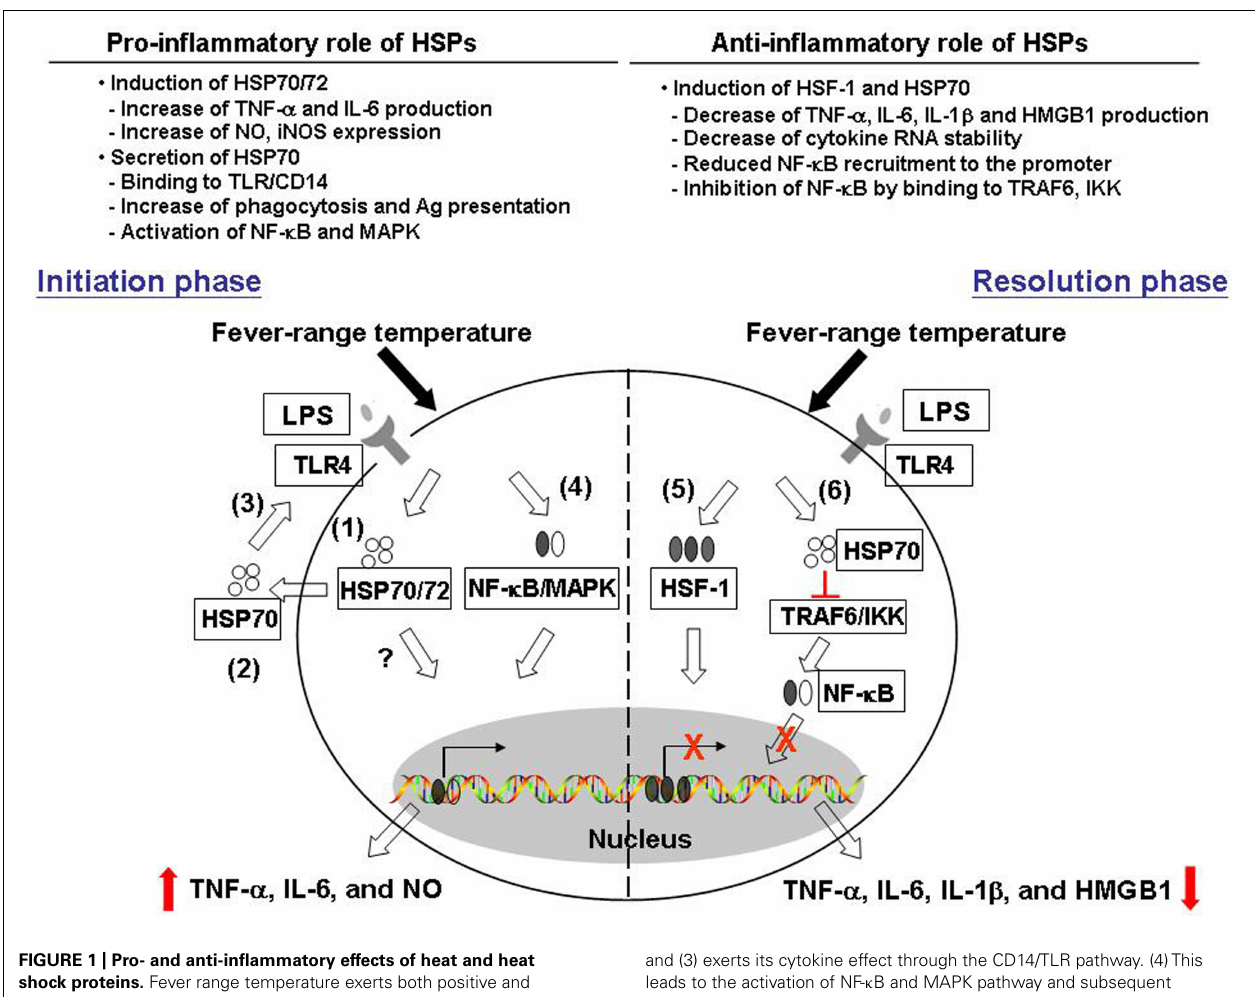
FIGURE 1 | Pro- and anti-inflammatory effects of heat and heat shock proteins. Fever range temperature exerts both positive and negative effects on macrophage pro-inflammatory cytokine production. We proposed that these opposing effects may depend on the activation stage of macrophages as well as the cellular location of heat shock proteins. First, in the initiation phase of macrophage activation, fever range temperature enhances the production of LPS-induced pro-inflammatory cytokinesTNF- α , IL-6, and NO. (1)This thermally enhanced cytokine production is associated with an induction of HSP70/72 in these cells. (2) HSP70 can then be released into the extracellular environment,